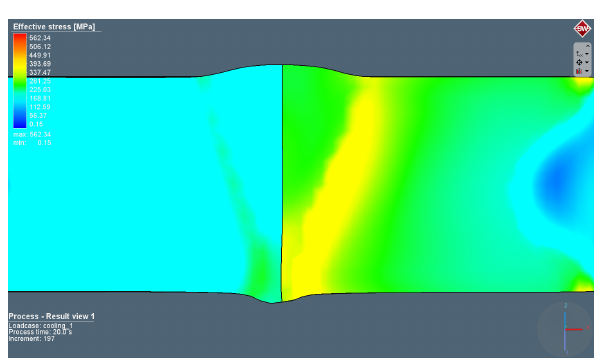
Figure 4: Effective stress distribution of simulated laser welded joint in cross section